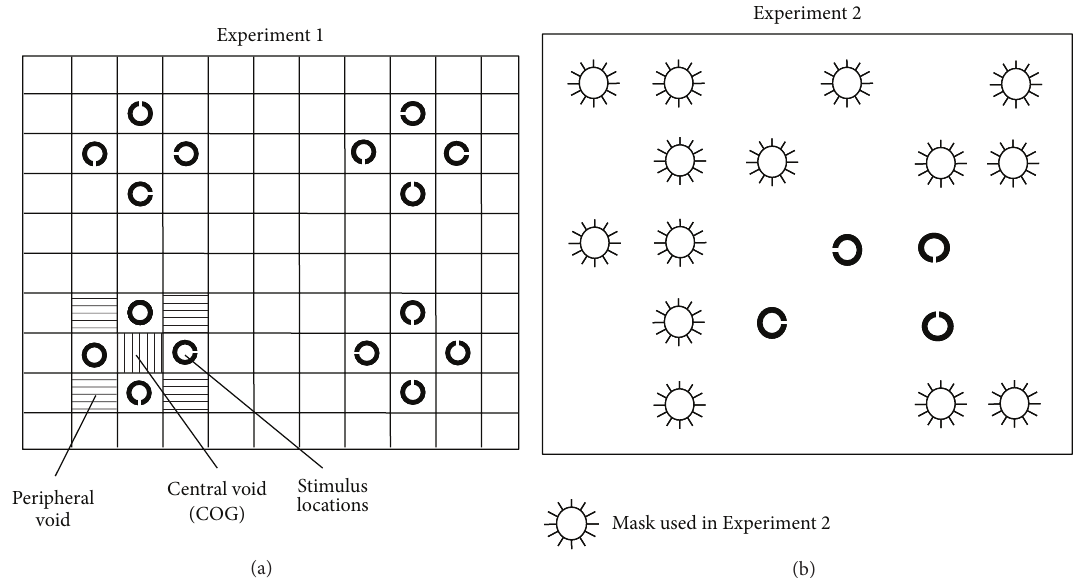
Figure 1: Example of the search displays used in Experiments 1 and 2. The grid (a) shows how the search display was partitioned for data analysis and was not visible in the experiment. In Experiment 1 (a), each cluster was partitioned into 4 stimulus regions (Landolt Cs), a central void region (marked by vertical lines), and 4 peripheral void regions (marked by horizontal lines). In Experiment 2 (b), a regular grid of same- sized squares was laid over the search display that contained 18 stimuli that were randomly distributed on 36 possible positions, resulting in equal numbers of stimulus regions and void